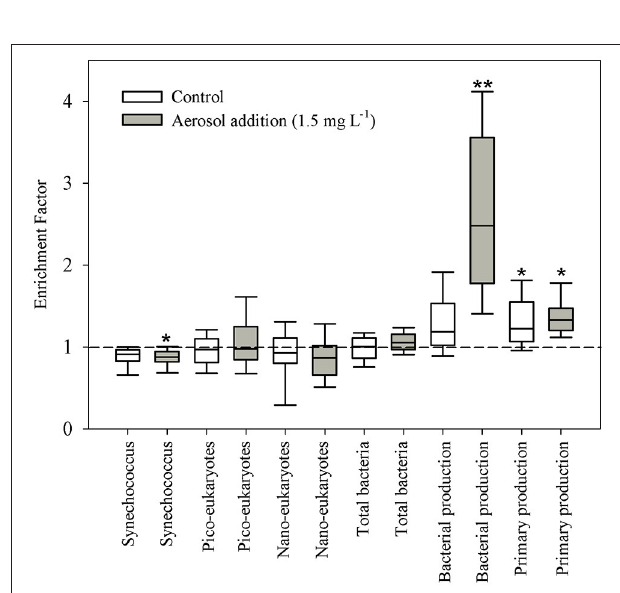
FIGURE 4 | Box-plot distribution of the abundance or activity enrichment factors (SML: SSL ratio). Central line indicates median value. Interquartile box plot of abundance and activity enrichment factors: bottom and top horizontal lines indicate the 10 and 90th percentiles respectively. * P < 0.05; ** P <